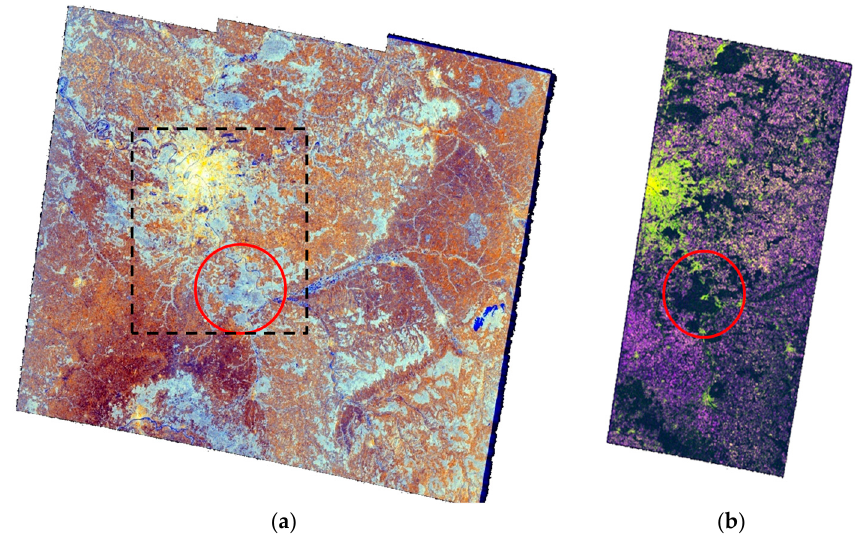
Figure 2. ( a ) Multi-polarization color-composite of the radar backscattering coefficient σ 0 image acquired on 18 March 2015: R: σ 0 , G: σ 0 , B: σ 0 / σ 0 ; ( b ) coherence derived from the 18–30 March 2015 acquisitions of the second sub-swath: R: | ρ VV | , G: | ρ VH | , B: | ρ VV | / | ρ VH | . The red circle corresponds to the Fontainebleau Forest. Paris is the bright feature in white-yellow, northwest of Fontainebleau. The dashed rectangle corresponds to the area shown in Figure 3.